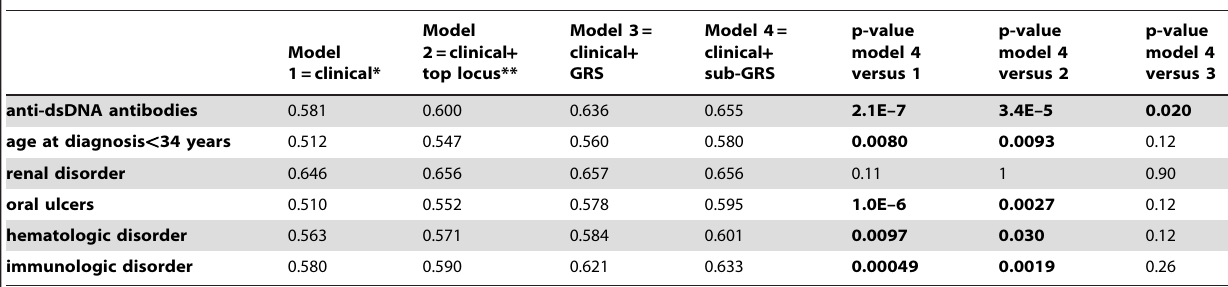
*disease duration and sex for all except early diagnosis; sex only for early diagnosis. **top locus adjusting for sex and duration: anti-dsdna, early diagnosis, oral ulcers= STAT4 ; renal= HLA-DR3 ; immunologic= KIAA1542 ; hematologic=